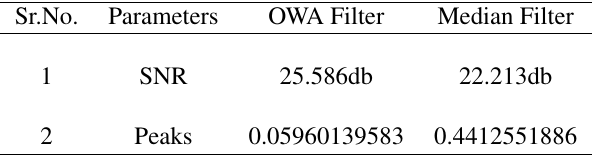
Table 1. Comparison of OWA and Median Filters